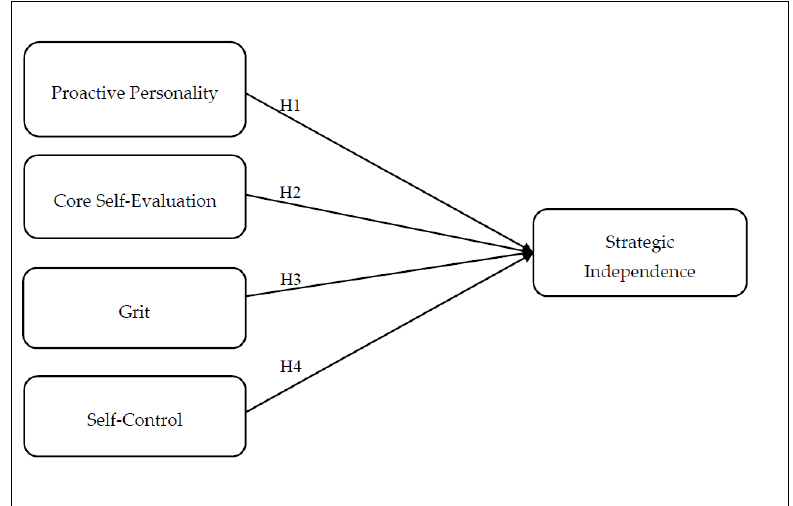
Figure 1. Conceptual model.